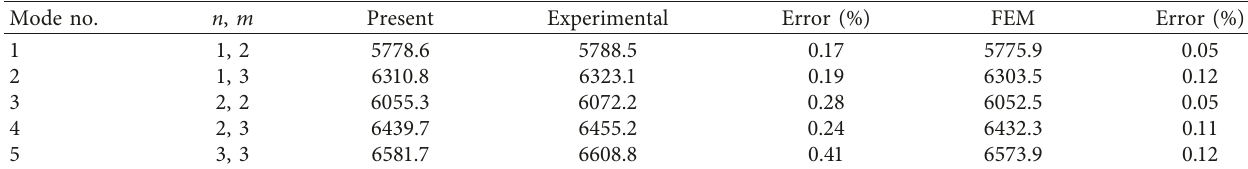
Table 4: Comparison of the natural frequencies for the isotropic spherical